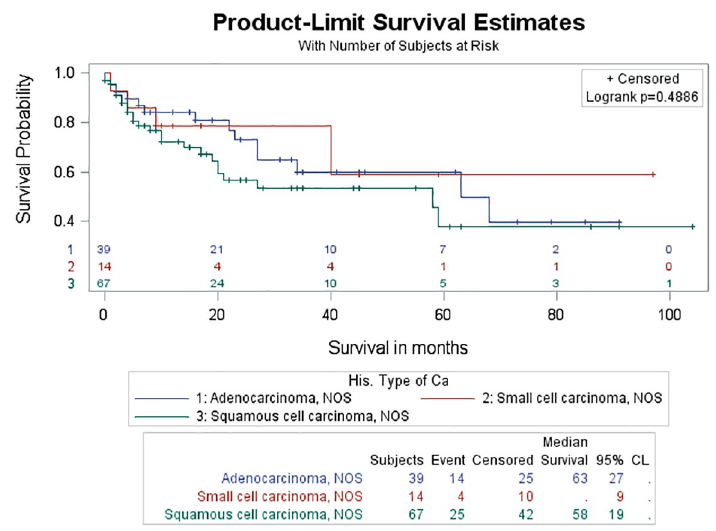
Fig 7. Survival curves between different types of lung cancer in the control group. There was no significant difference in survival rate between different types of lung cancer in the control group (log rank test, p =